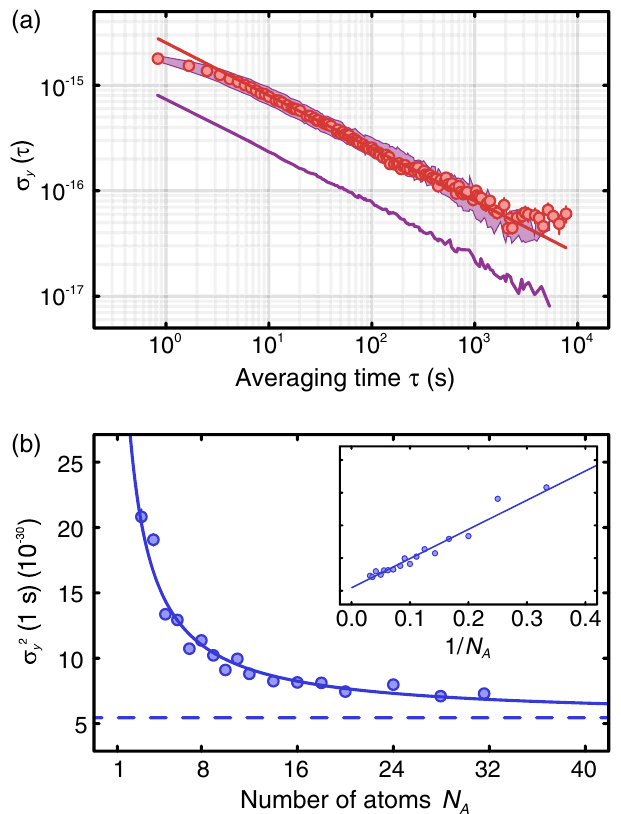
FIG. 4. Stability results. (a) Fractional Allan deviation σ y obtained via self-comparison as a function of integration time ffiffiffi p τ (circles). Fitting a 1 = τ behavior past an initial lock onset time ffiffiffi p τ (red solid line), we find 2 . 5 × 10 − 15 = . The shaded area denotes MC results. The purple solid line shows the quantum projection noise limit obtained from MC by switching off all other noise sources. (b) Based on atom-by-atom feedback control, we perform a series of self-comparisons with fixed atom number ffiffiffi p τ N . Shown is the Allan variance σ 2 at 1 second (from a 1 = fit) A y as a function of N . Inset: Allan variance σ 2 as a function of 1 =N . y A A σ 2 σ 2 Solid lines show a fit with a functional form σ 2 , ffiffiffiffiffiffiffi ∞ þ y ¼ p N A N where σ scales as 1 = N A A